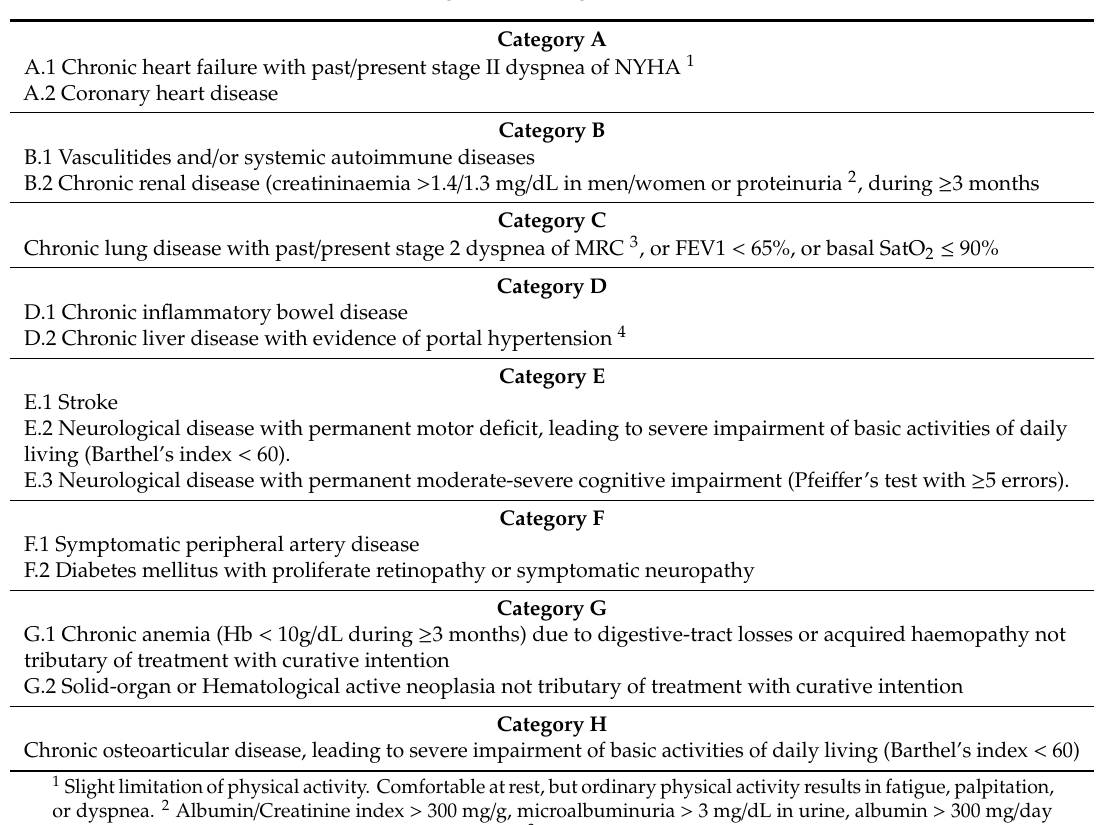
Table 1. Functional definition of Polypathological Patient: the patient who su ff ers chronic diseases included in two or more of the following clinical